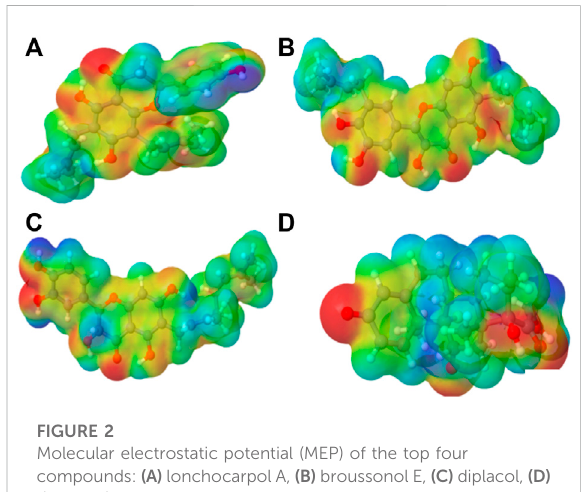
FIGURE 2 Molecular electrostatic potential (MEP) of the top four compounds: (A) lonchocarpol A, (B) broussonol E, (C) diplacol, (D)